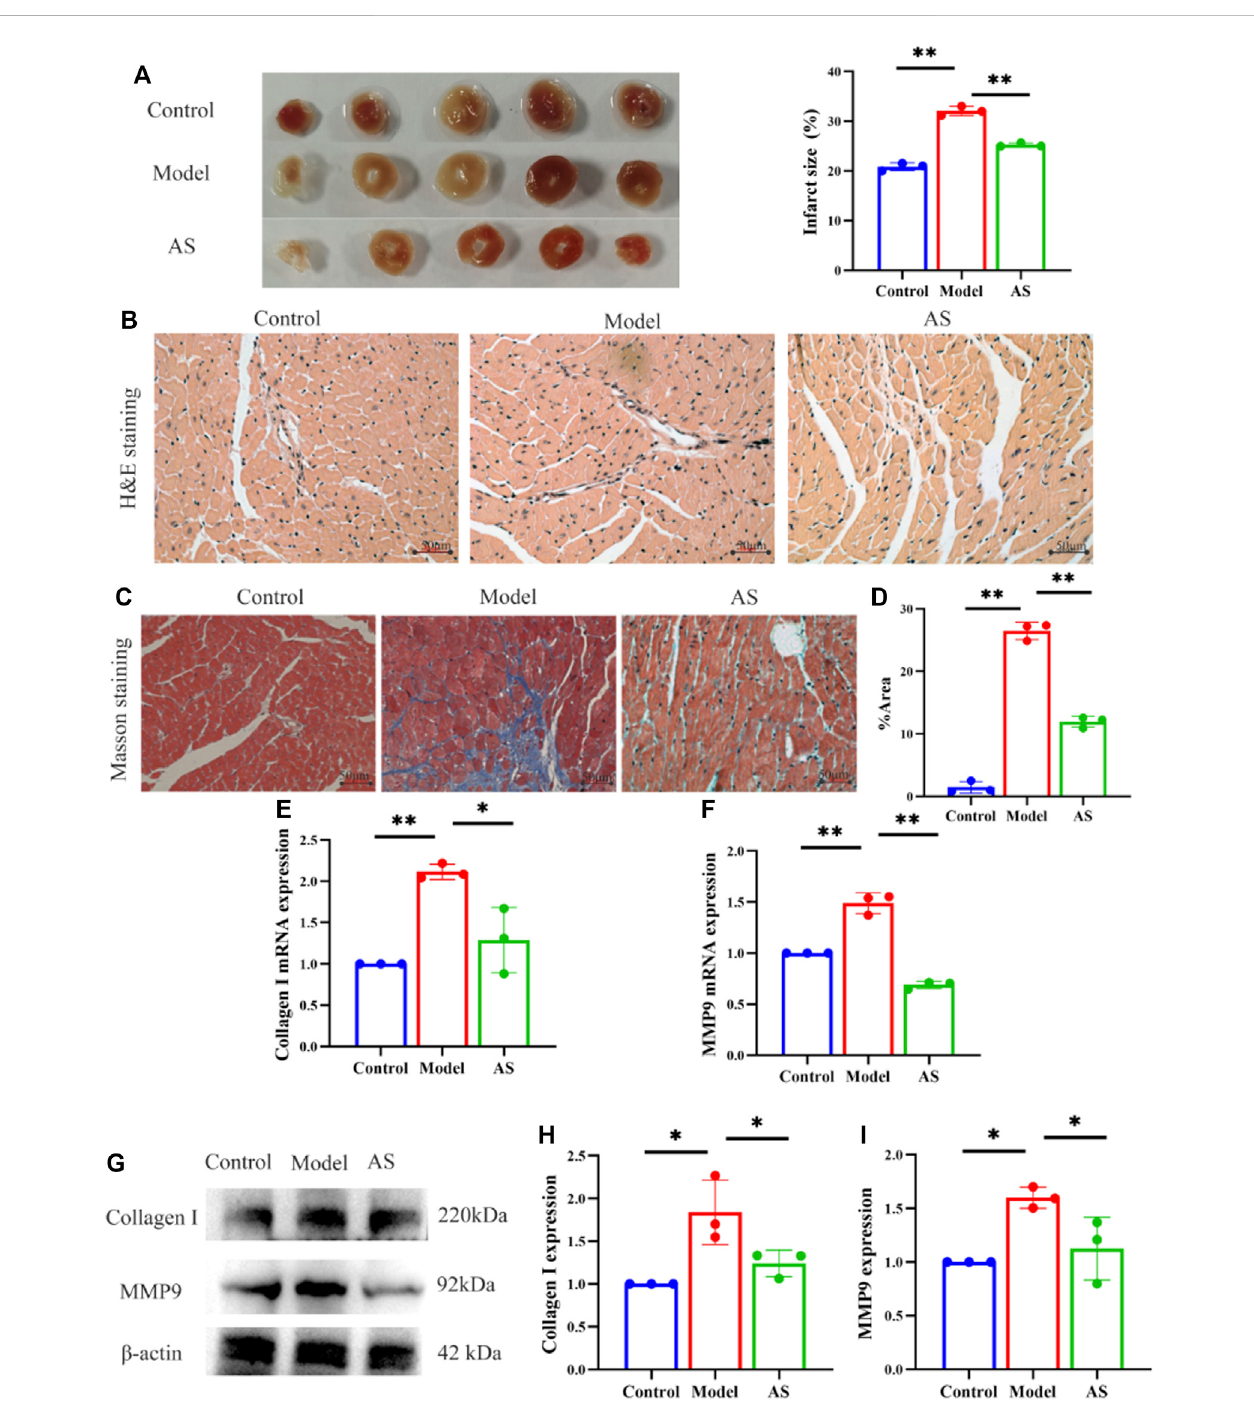
FIGURE 2 ASattenuatesmyocardialpathologicalinjury. (A) Representativeimagesandcalculatedinfarctsizeofthemyocardiumofmice. (B) Representativeimages of H&E staining. (C) Representative images of Masson staining. (D) Fibrosis area as percentage, results are expressed as mean ± SD, n = 3, ** p < .01. (E) Quantitative analysis of Collagen I mRNA, results are expressed as mean ± SD, n = 3, ** p < .01, * p < .05. (F) Quantitative analysis of MMP9 mRNA, results are expressed as mean ± SD, n = 3, ** p < .01. (G) Western blot analysis of Collagen I and MMP9 expression in mice. (H) Quantitative analysis of Collagen I, results are expressed as mean ± SD, n = 3, * p < .05. (I) Quantitative analysis of MMP9, results are expressed as mean ± SD, n = 3, * p <